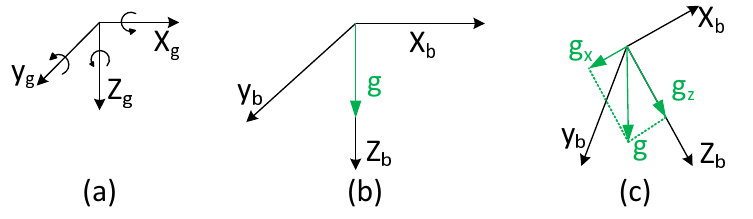
Figure 1. Gravitational acceleration and different coordinate frames: ( a ) Global frame. ( b ) Body frame without rotation. ( c ) Body frame rotation around the y -axis.